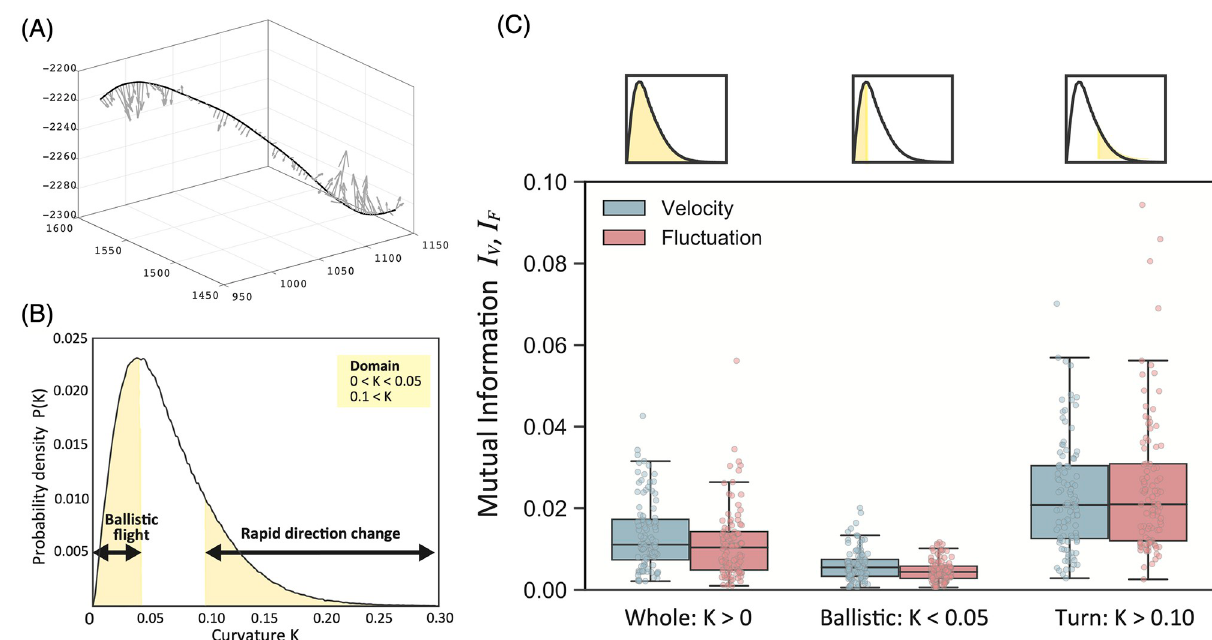
Fig 9. Curvature vectors and mutual information obtained for different inputs. (A) The flock center-of-mass trajectory and its curvature vectors at each point. (B) The probability density P ( K ) for all series of data where δ t = 5 steps. We defined the region with curvature K < 0.05 as the ballistic region, and the region for which K > 0.10 as the group turning region. (C) Mutual information I V � I ({ V leader ( t ), V follower ( t )}; K ( t )) and I F � I ({ F leader ( t ), F follower ( t )}; K ( t )) for each region. The mutual information (i.e., I V , I F ) in the group turning region is significantly larger than in the ballistic region. The detailed statistical test results are listed in S1